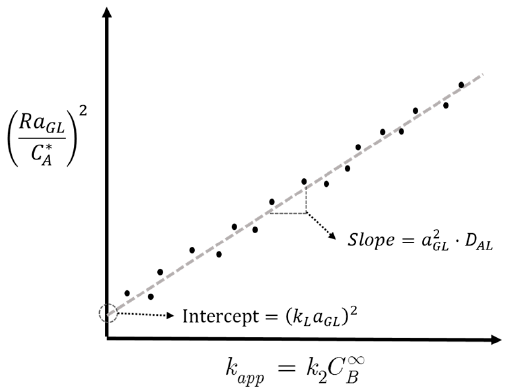
Figure 1. Schematic representation of the Danckwerts’ plot method.